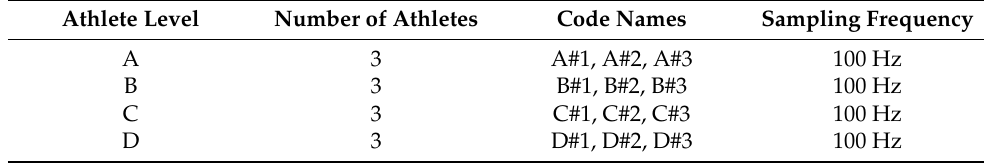
Table 1. Information for the athlete movement pressure measurement dataset used in this paper.